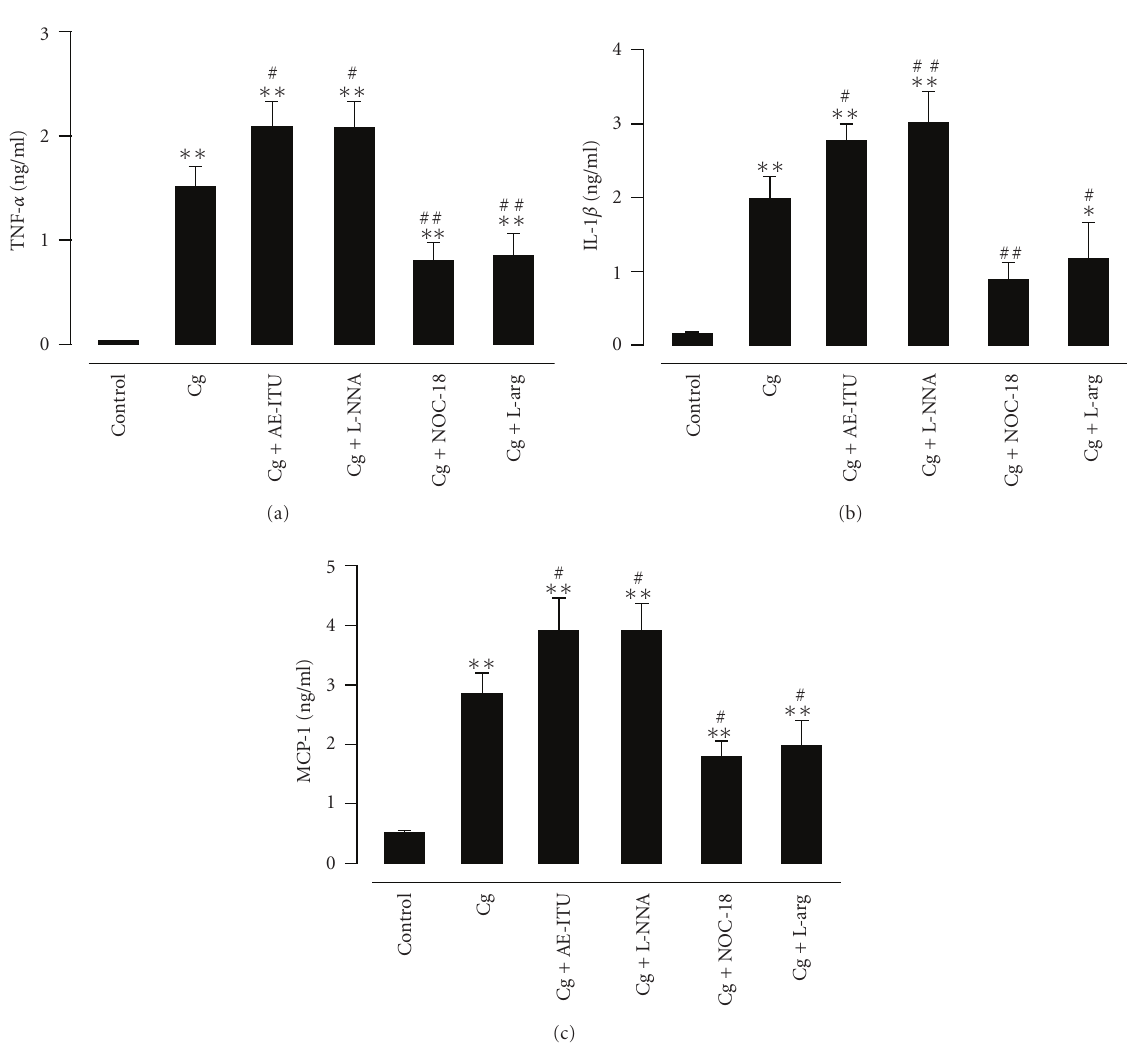
Figure 7: E ff ects of AE-ITU, L-NNA, NOC-18 and L-arginine on the release of cytokines. Tumor necrosis factor- α (TNF- α ) (a), interleukin- 1 β (IL-1 β ) (b) and monocyte chemoattractant protein-1 (MCP-1) (c) levels in the pleural exudates 6 hours after Cg challenge. Data are expressed as mean ± S.E.M. from 6 to 8 rats. ∗ P < . 05, ∗∗ P < . 01 as compared to control group; # P < . 05, ## P < . 01 as compared to Cg